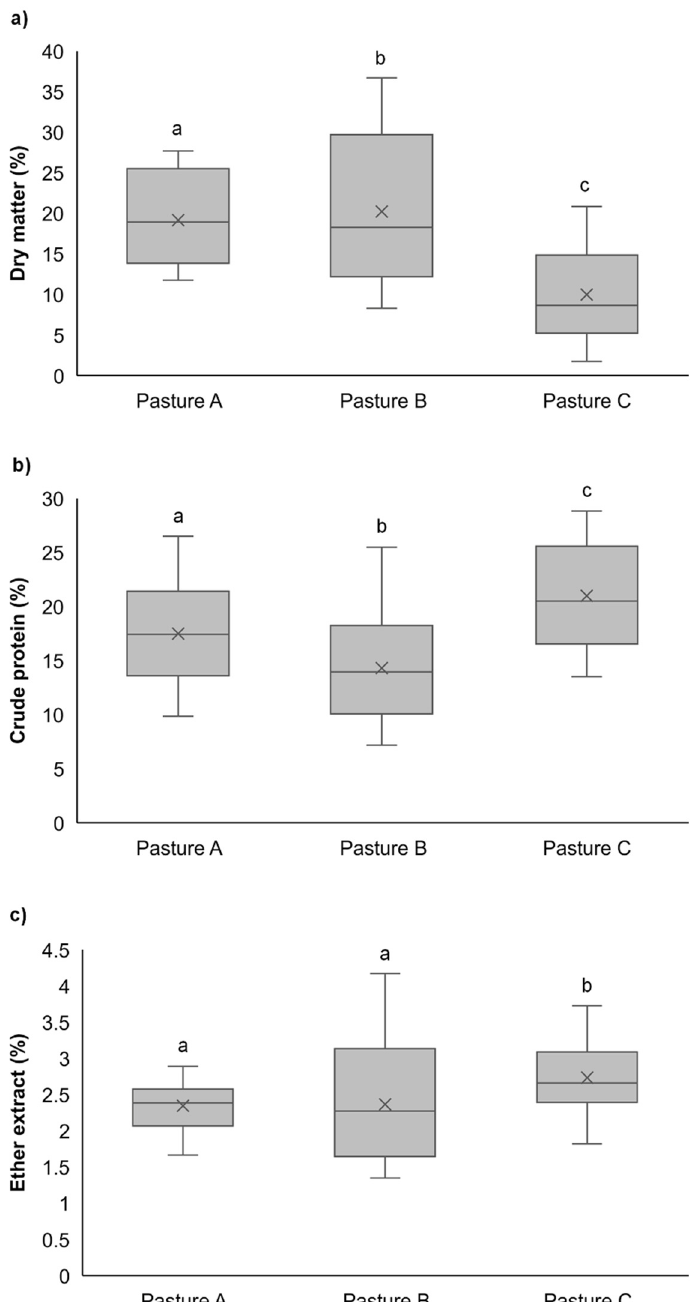
Figure 5. Boxplots representing the variation of the nutritive values of forage plants among the three pastures located at different altitudinal levels. Parameters are ( a ) dry matter; ( b ) crude protein and ( c ) ether extract. Bold line represents the median, x signals the mean, and the bottom and top of the box represent the lower and upper quartiles. Different letters above each box indicate significant differences in nutritive values between pastures (Kruskal–Wallis test, p < 0.05).